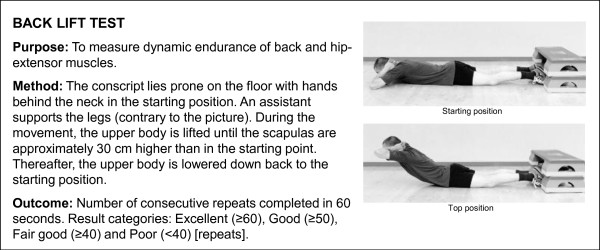
Description of back lift test. The test is based on practice in the Finnish Defence Forces.